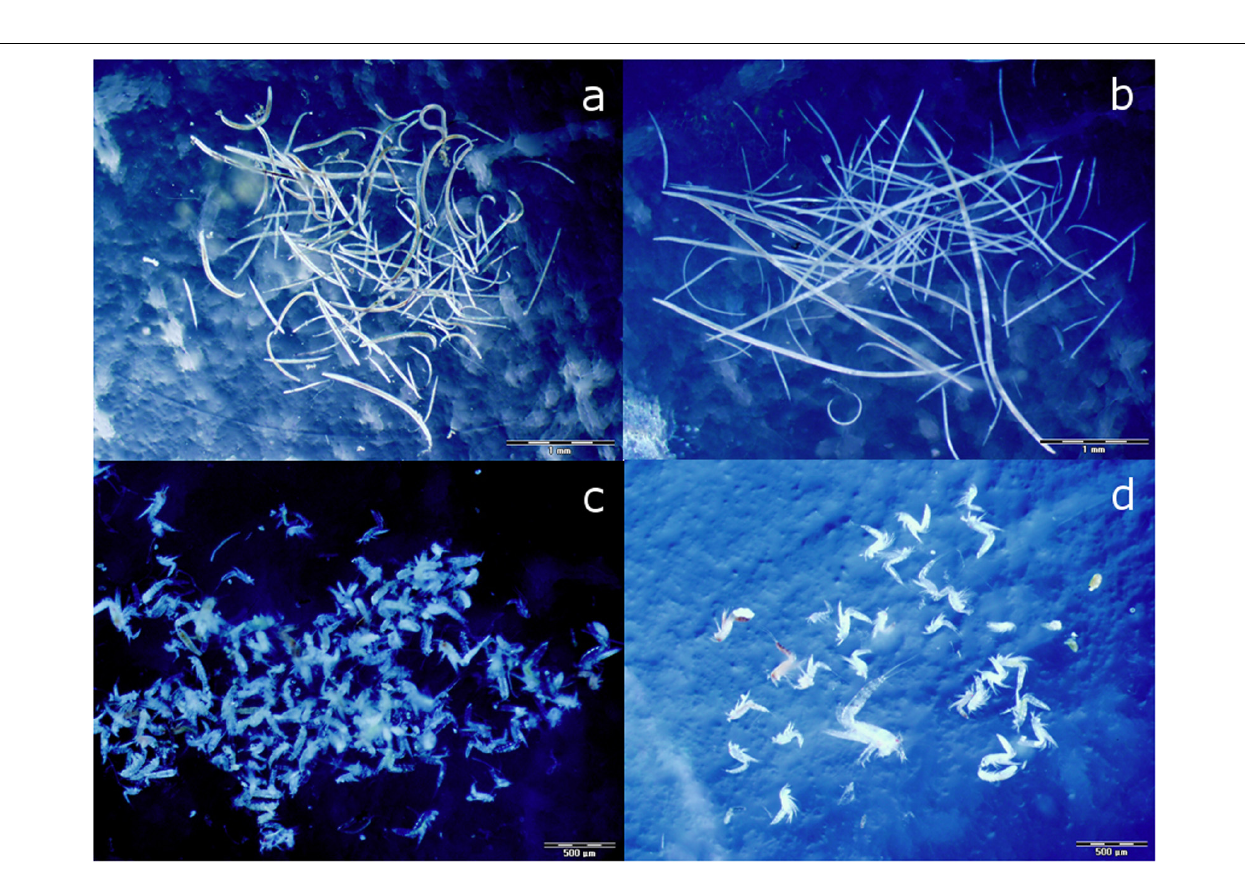
FIGURE 2 | Sorted nematodes from experimental cores; reference assemblage-OUT (a) characterized by smaller specimens, and fish farm assemblage-CAGE (b) characterized by larger specimens, and sorted harpacticoids from experimental cores; reference assemblage-OUT (c) , and fish farm assemblage-CAGE (d) . The scale bar is 1 mm (a,b) and 0.5 mm (c,d)